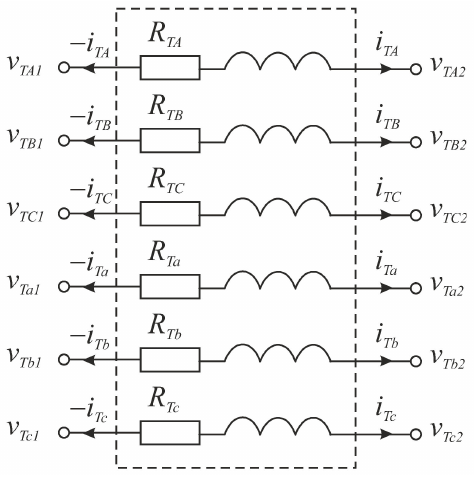
Figure 7. Calculation scheme of a three-phase